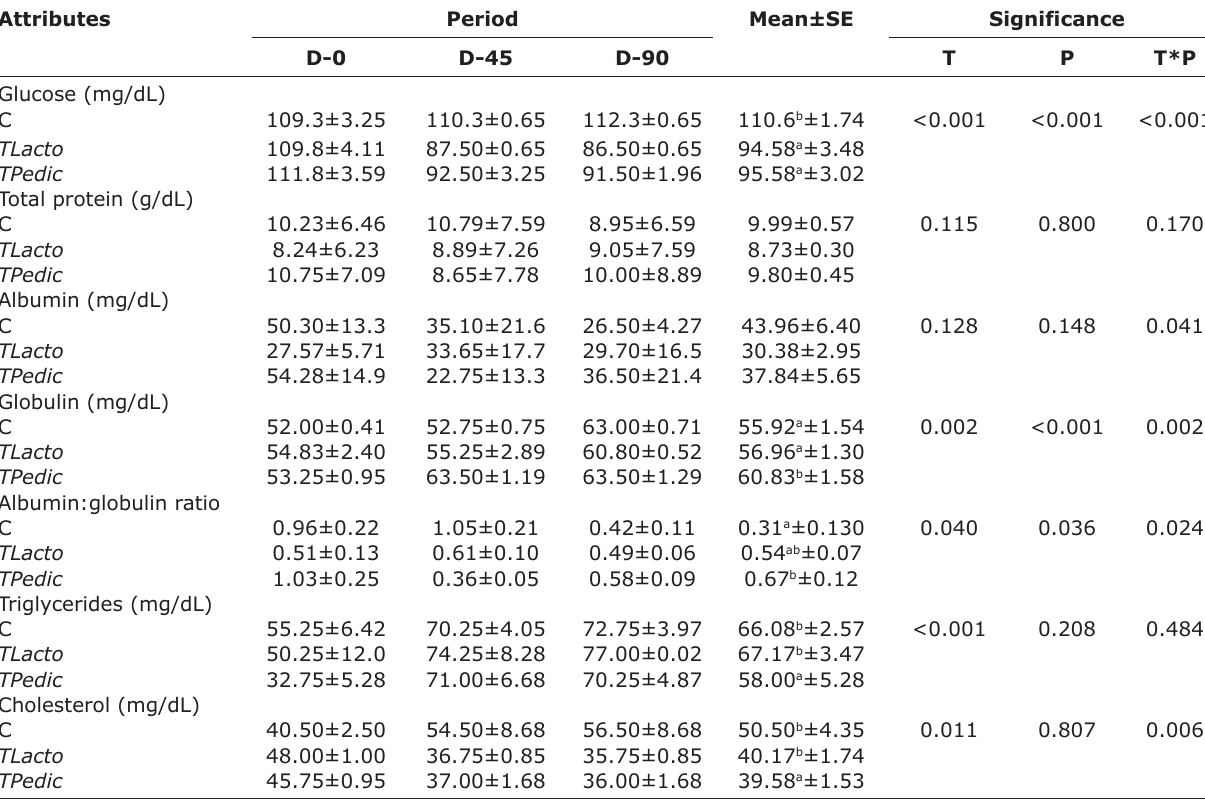
Table-3: Effect of probiotics on blood biochemical profile in grower